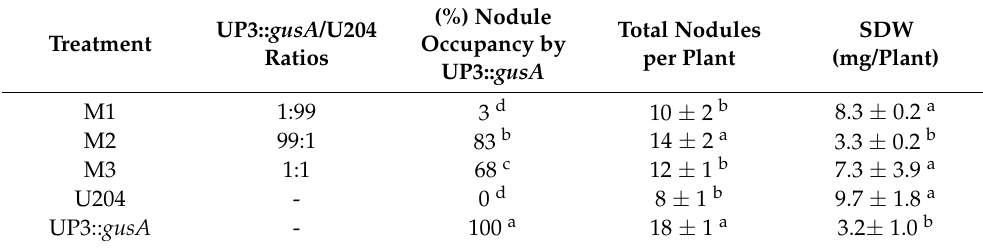
Table 5. Nodulation competitiveness test 2. Percentages of nodule occupancy and symbiotic effi- ciency on T. repens by strain UP3:: gusA , under competitiveness experiments. Controls corresponded to seeds inoculated with UP3:: gusA or U204 (10 6 CFU/seed). The ratios of UP3:: gusA :U204 in co- inoculated treatments corresponded to concentrations between 10 6 and 10 4 CFU/seed (Table 2). SDW, shoot dry weight. Results (mean ± standard deviation) are from one of three independent experiments with a similar trend. Different letters indicate statistical differences between values within each column ( p <